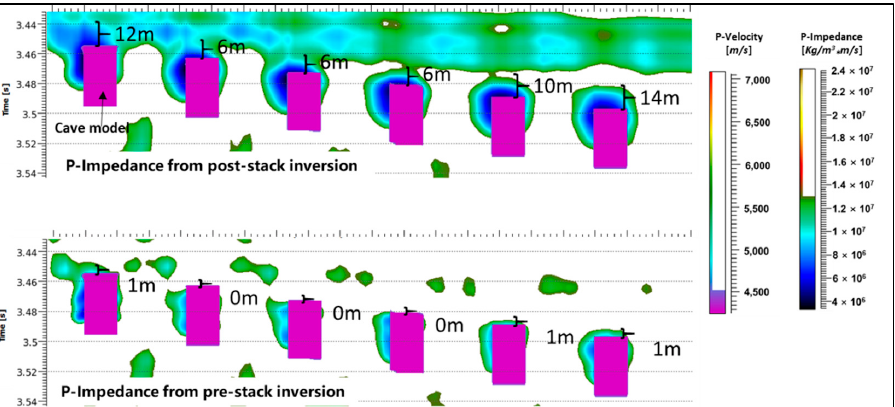
Figure 7. Comparison of P-impedance between post-stack inversion and pre-stack inversion. Purple rectangles indicate models with different distances from the upper surface. Pre-stack inversion shows more effective prediction results.